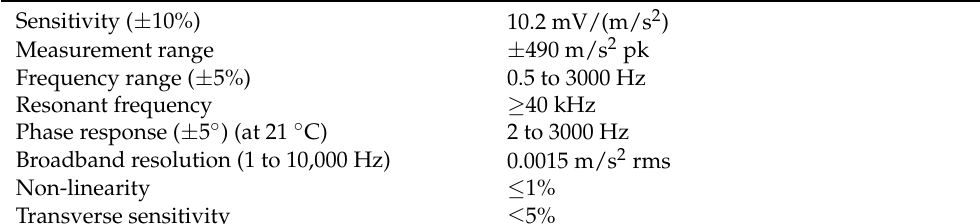
Table 4. Microphone’s parameters.